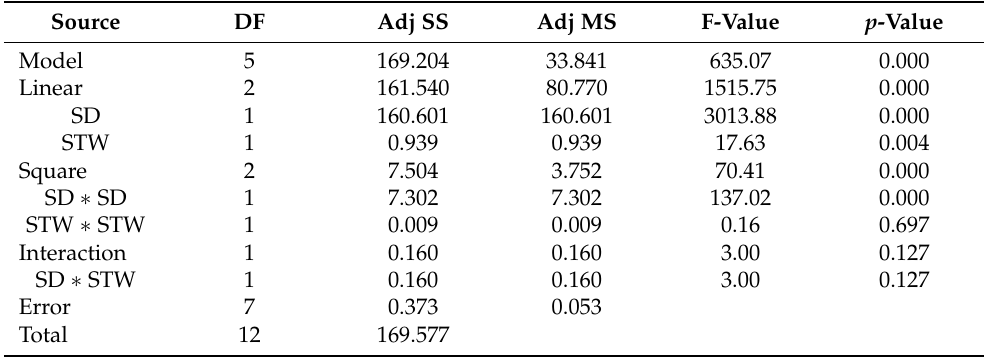
Table 7. Dispersion analysis of central composite design for